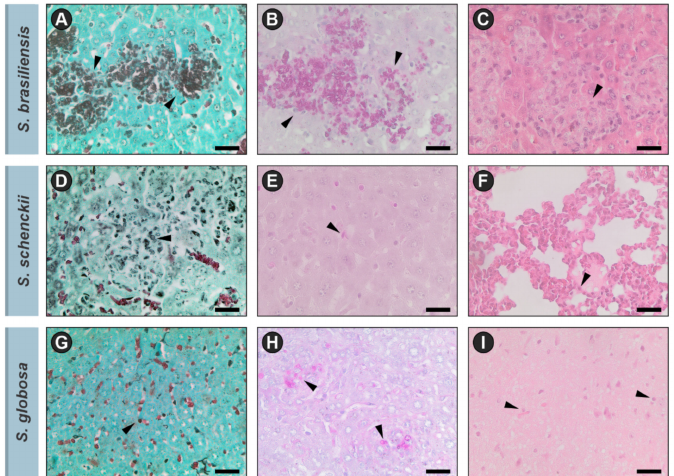
Figure 6. Histopathological patterns of Sporothrix species. Black arrows indicate Sporothrix yeasts. ( A – C ) S. brasiliensis stained by GMS, PAS and HE, respectively; ( D – F ) S. schenckii stained by GMS, PAS and HE, respectively; ( G – I ) S. globosa stained by GMS, PAS and HE, respectively. GMS: Gomori methenamine silver, PAS: periodic acid–Schiff-stained, HE: hematoxylin and eosin. Bar = 25 µ